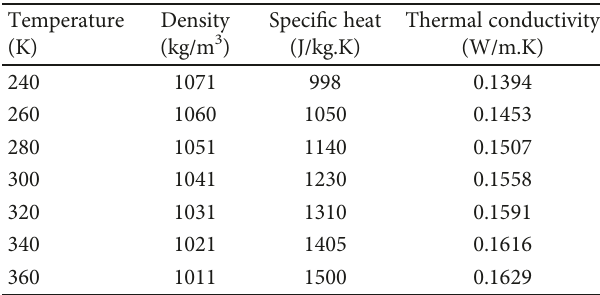
Table 2: Material properties for polystyrene [20].